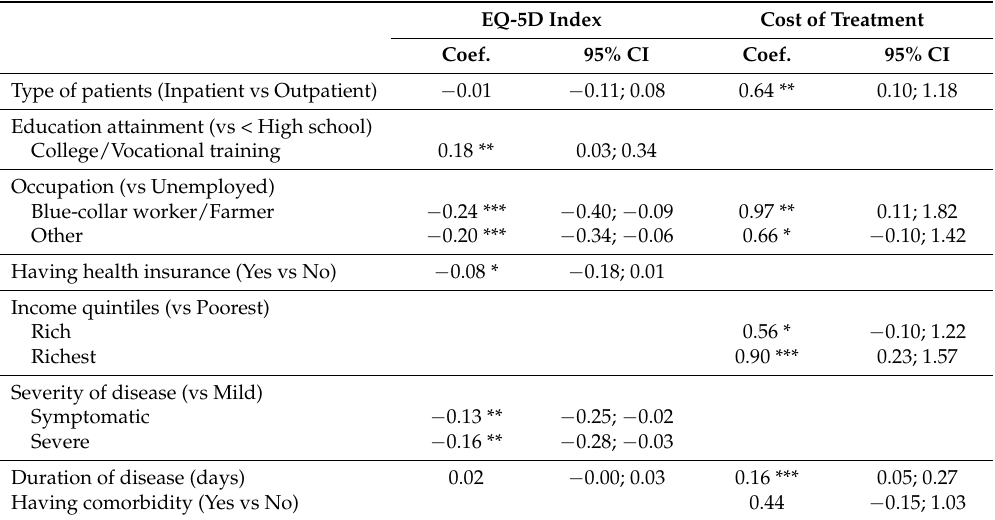
Table 4. Factors associated with quality of life and the transformed logarithm of the cost of dengue fever treatment among